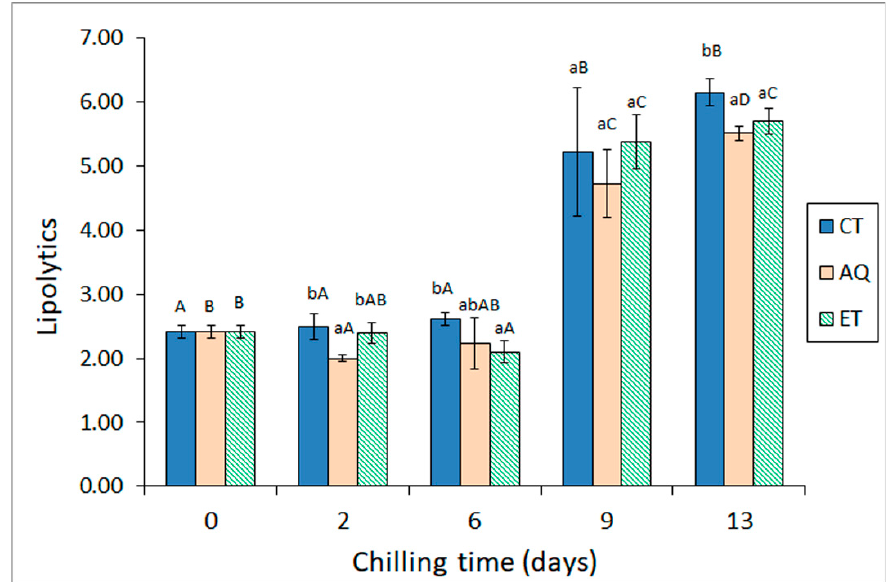
Figure 1. Evolution of lipolytic counts (log CFU·g − 1 ) * in chilled hake subjected to different icing conditions **. * Average values of three replicates ( n = 3); standard deviations are indicated by bars. For each chilling time, different lowercase letters denote significant ( p < 0.05) differences as a result of icing conditions. For each icing condition, different capital letters denote significant ( p < 0.05) differences as a result of chilling time. ** Icing conditions as expressed in Table 1.